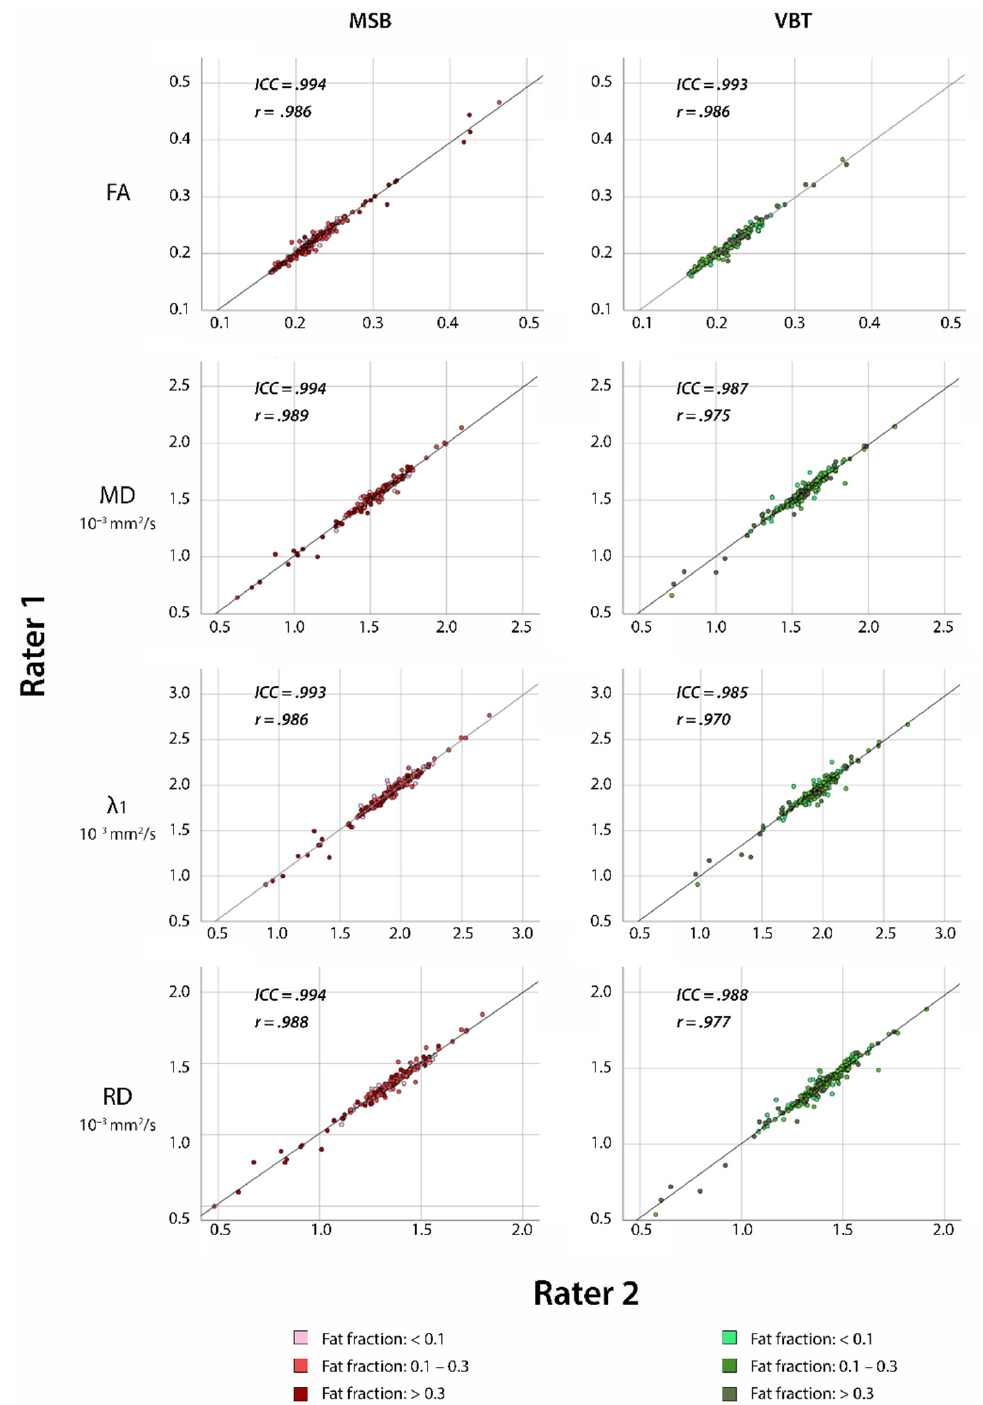
Figure 4. Scatter plots of correlation between inter-rater measurements for VBT and MSB in patients with neuromuscular diseases with Pearson correlation coefficient (r) and intraclass correlation coefficient (ICC) included in each graph.